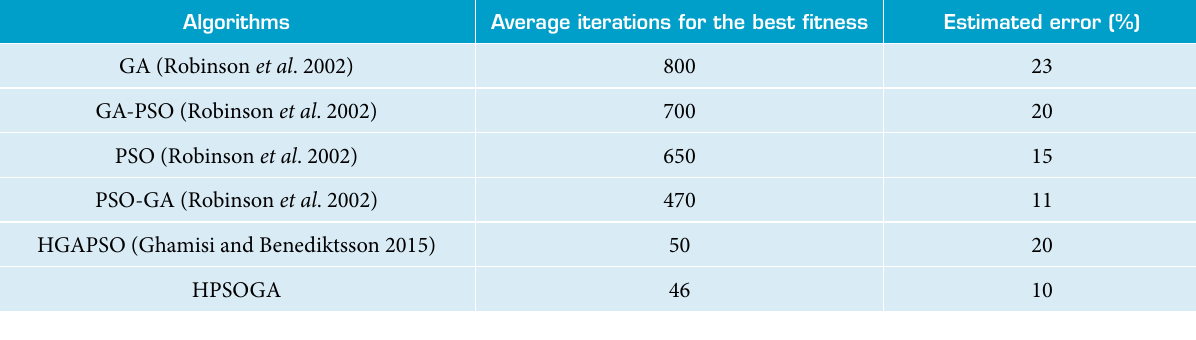
Figure 10. Comparison of average convergence curves in our approach. Table 2. Algorithms comparison with other